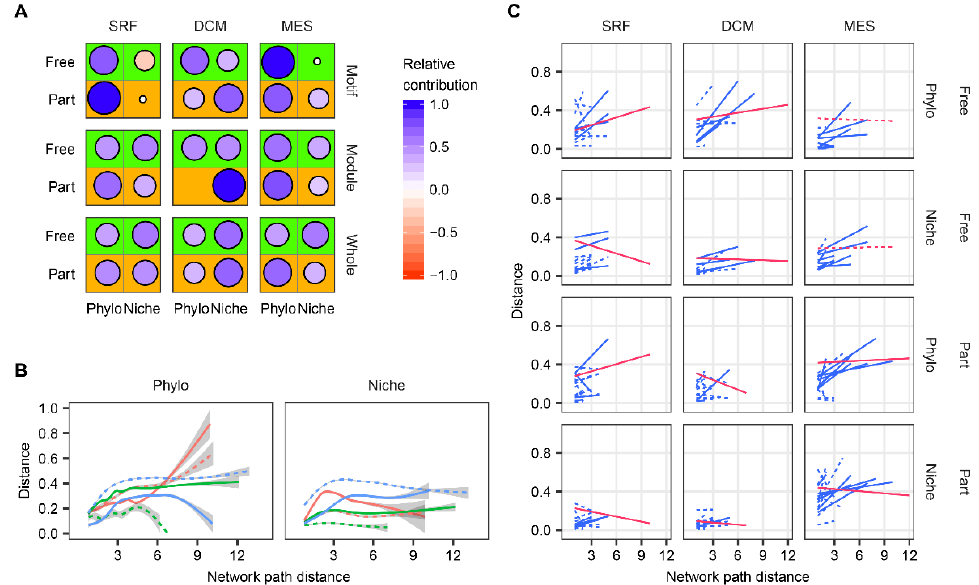
Figure 3. The effects of species phylogeny and niches on marine microbial network constructions. ( A ) The relative contributions of species phylogeny (Phylo) and niche distance to network construction across motif, module and whole-network (whole) levels in free-living (Free) and particle-associated (Part) communities at surface water layer (SRF), deep chlorophyll maximum layer (DCM) and mesopelagic zone (MES), where pattern size and color intensity are the strength of relative contribution, and colors represent the positively (blue) or negatively (red) relative contributions. ( B ) The relationships between network path distance and phylogeny or niche distance at the whole network level, where color represent depth layers (red: SRF; green: DCM blue: MES), and line type represents community fractions (solid: Free; dashed: Part). The curves were fitted by generalized additive models. The shaded region indicates standard errors of the curves. ( C ) The linear relationships between network path distance and phylogeny or niche distance across modules (blue line) or within the same modules (red line), where line type is the statistical significance of linear regression analysis (solid: p < 0.05).